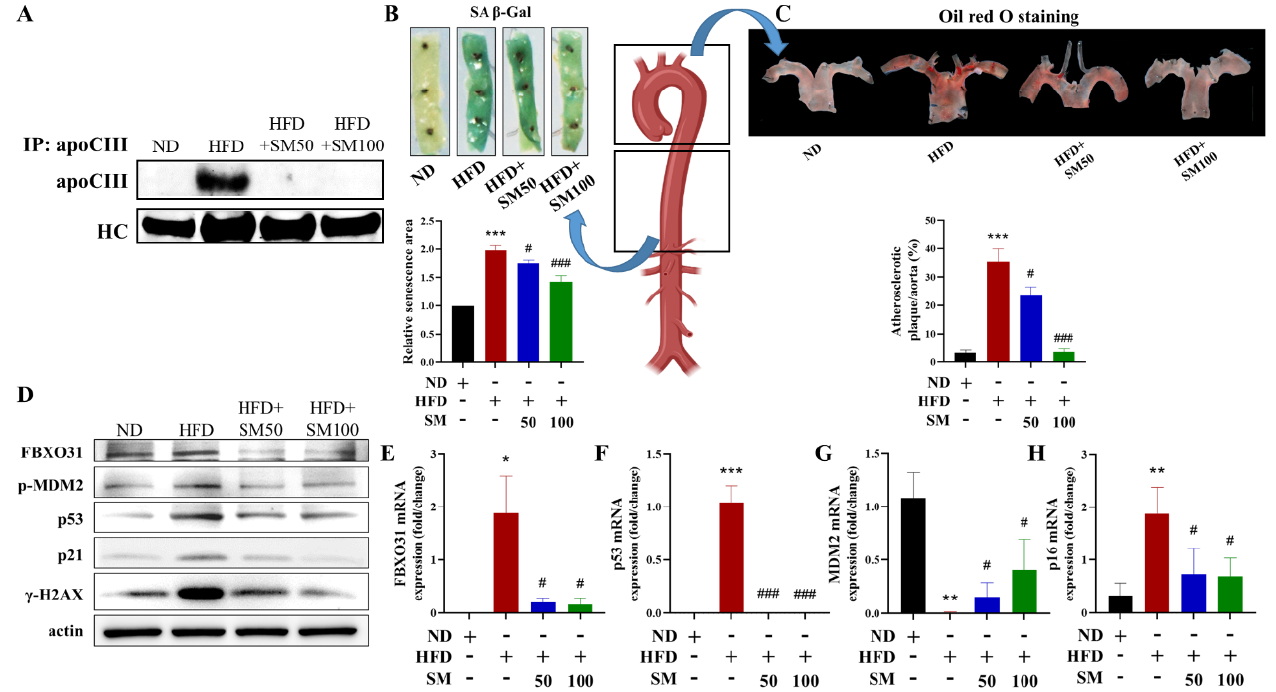
Figure 5. Pro-senescent effect of endogenous AC3RL in hamsters. Syrian hamsters were fed chow diet (control), HFD, or HFD supplemented with 50 mg/kg SM (HFD + SM50) or 100 mg/kg SM (HFD + SM100) via oral gavage for 18 weeks ( n = 10 per group). ( A ) ApoC3 in LDL, ( B ) SA- β -gal staining, ( C ) Oil Red O staining, ( D ) Western blotting, ( E ) FBXO31 mRNA, ( F ) p53 mRNA, ( G ) MDM2 mRNA, ( H ) p16 mRNA. * p < 0.05, ** p < 0.01, *** p < 0.001 vs. ND group; # p < 0.05, ### p < 0.001 vs. HFD